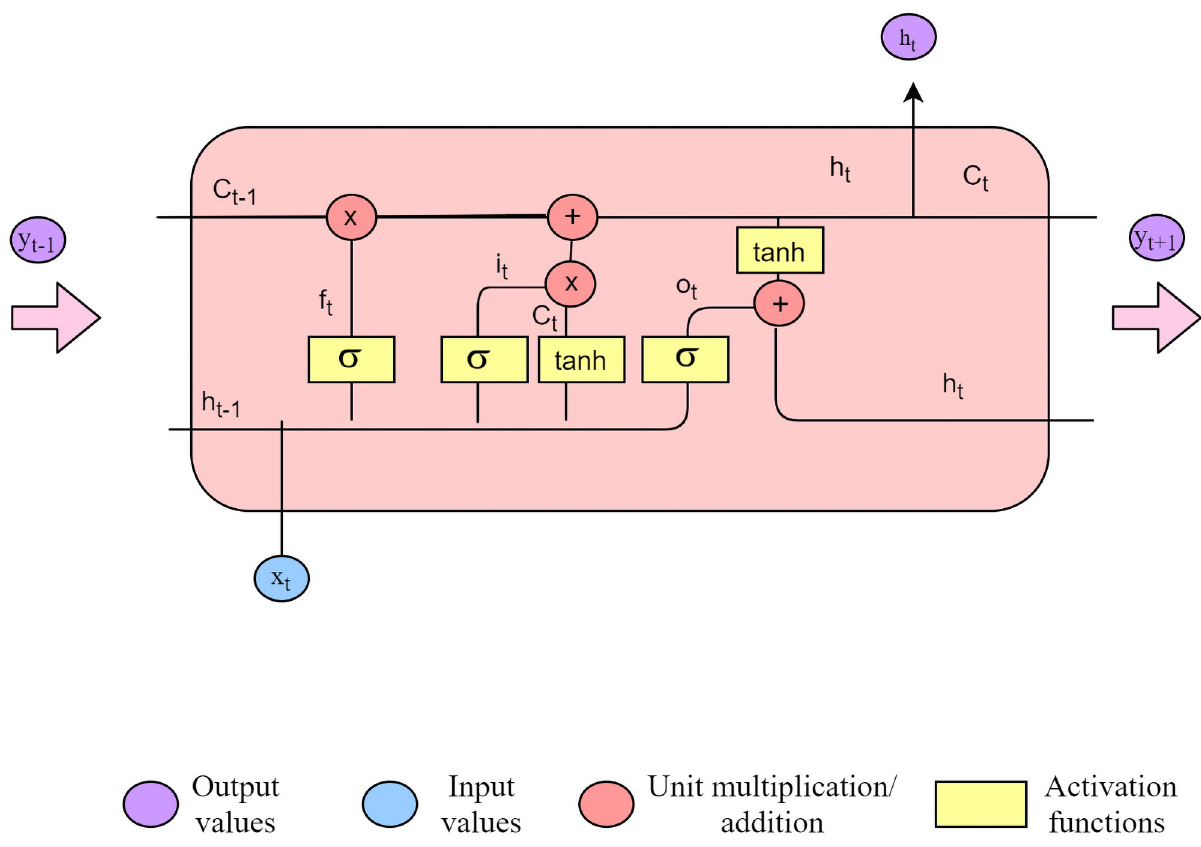
Fig 3. Variation of population density, rainfall, temperature and wind speed in the considered time period (2010-2019).